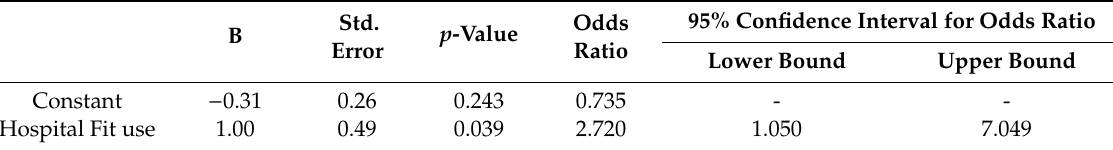
Table 4. Univariate logistic regression analysis—the association between the achievement of functional recovery on POD1 and Hospital Fit use.